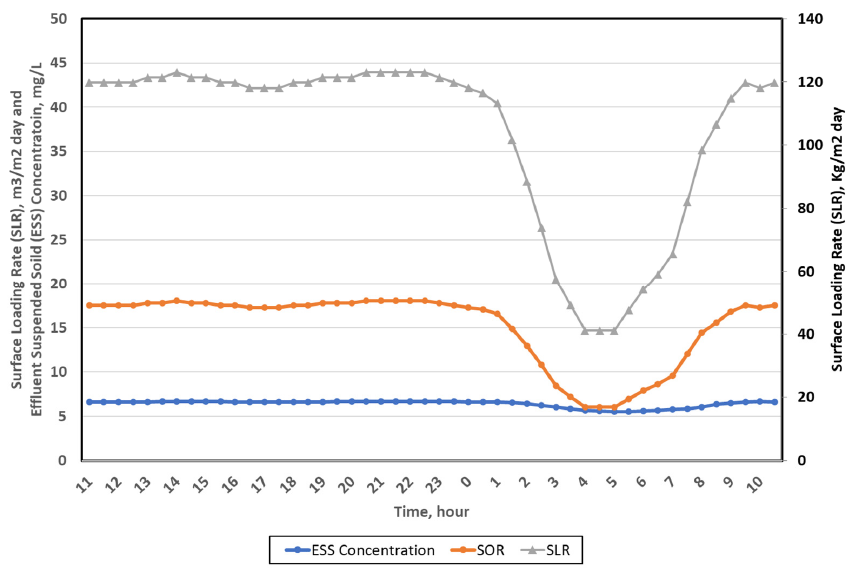
Figure 9. Simulation results of hourly secondary effluent SS concentrations and corresponding hourly SORs and SLRs at the secondary clarifier at plant B.